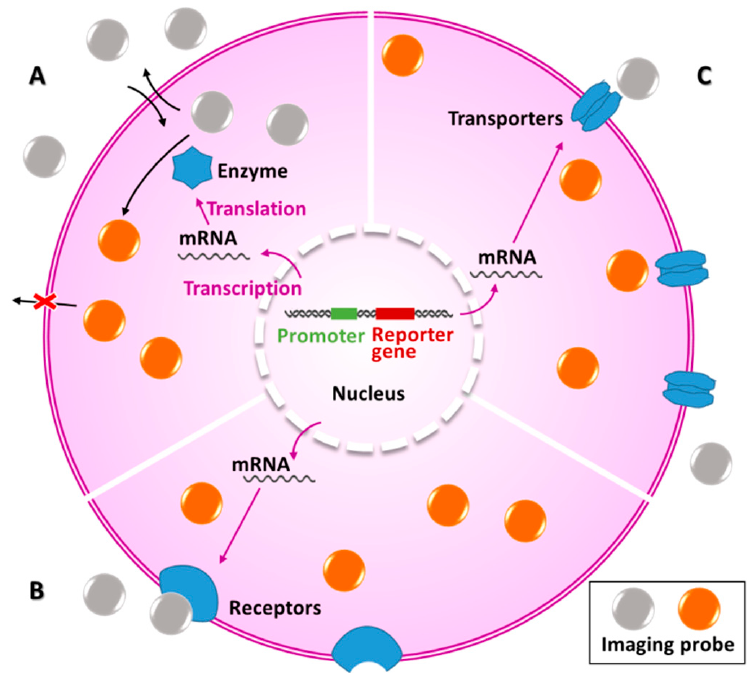
Figure 2. The major types of reporter gene expression in radionuclide imaging, based on ( A ) enzymes, ( B ) receptors, and ( C ) transporters.